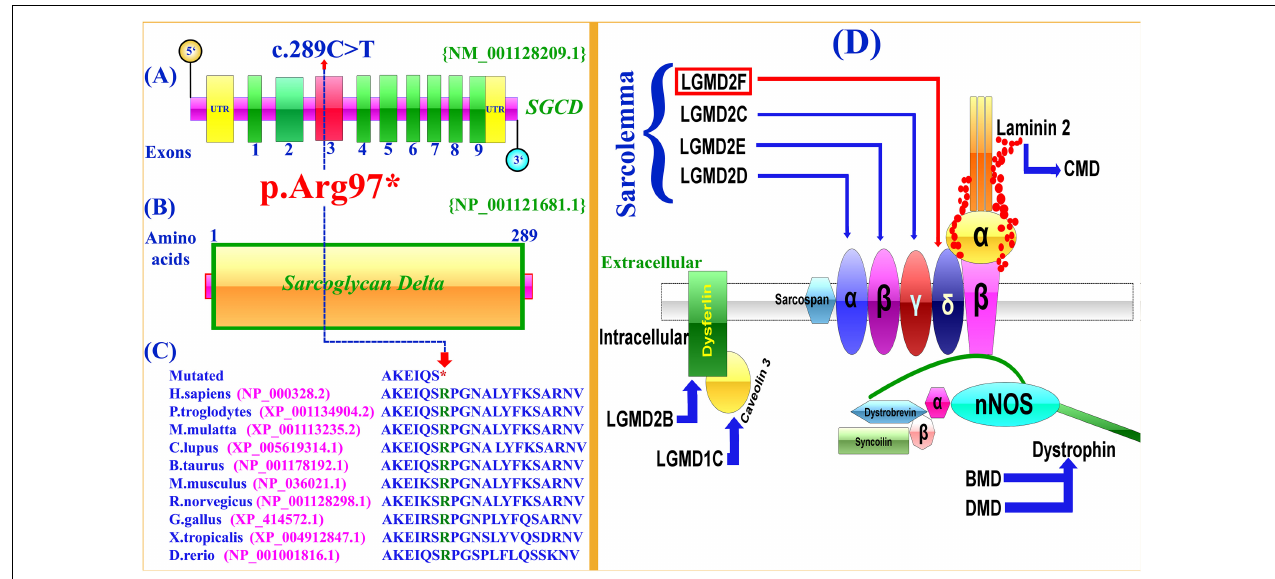
FIGURE 2 | Schematic representation of exons and protein product of SGCD gene. (A,B) Arrows show the position the mutation (c.289C > T; p.Arg97 ∗ ) identified in the present study. (C) Conservation of the Arg (R) 97 amino acid across different species. Notably, the nonsense mutation (c.298C > T) results in a premature stop codon (TCA). (D) Schematic representation of the sarcoglycan complex. The intracellular and extracellular regions of sarcoglycans are separated by a cell membrane. Different sarcoglycans, α , β , γ , δ , dysferlin, caveolin 3, dystrophin and laminin are shown and associated disorders are also shown using